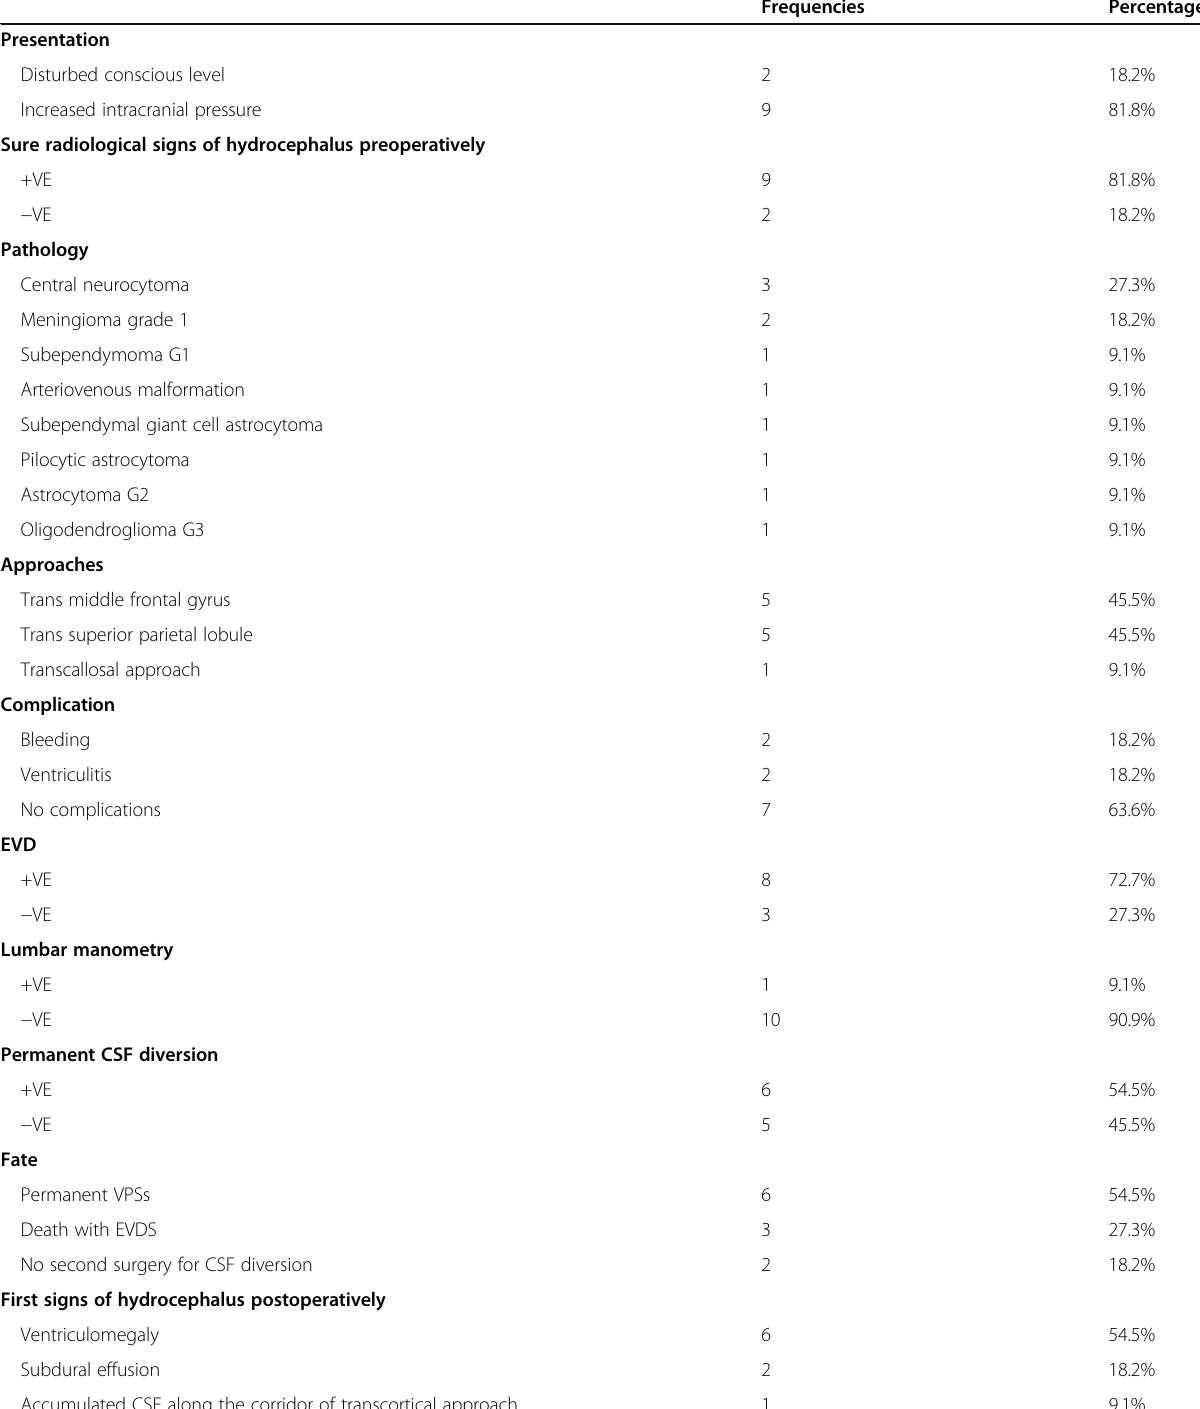
Table 1 The summary of our results